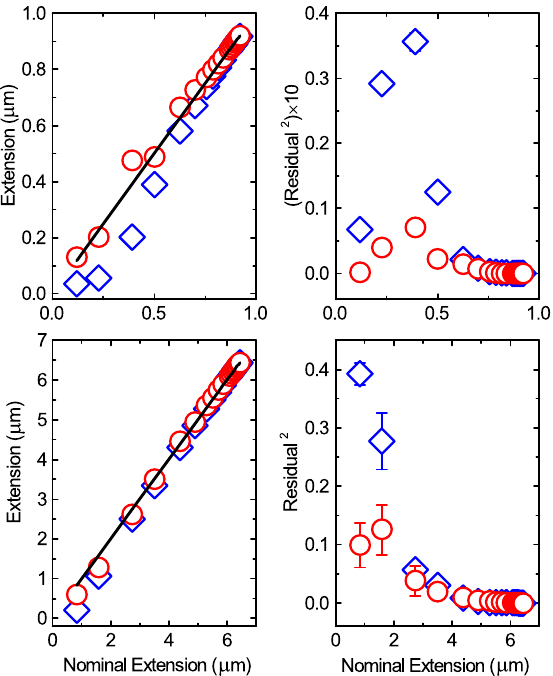
Figure 4. Improvement in measuring axial position using skew position shift rather than mean. Top row) Left) The calculated extension from simulations through using either the mean (blue diamonds) or the skew distribution position (red circles) as a function of nominal extension expected from the WLC, for a 1 : 0 m m tether. The black line indicates measurement equal to the nominal extension. Right) Residuals squared for difference between measured and nominal extension using same data as left. Bottom row) Same as top except for 7 : 0 m m tether. Error bars are standard error of the mean with n=5.